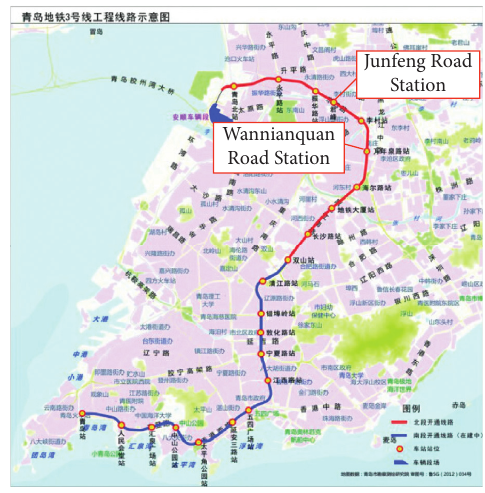
Figure 1: Qingdao Metro Line 3 project